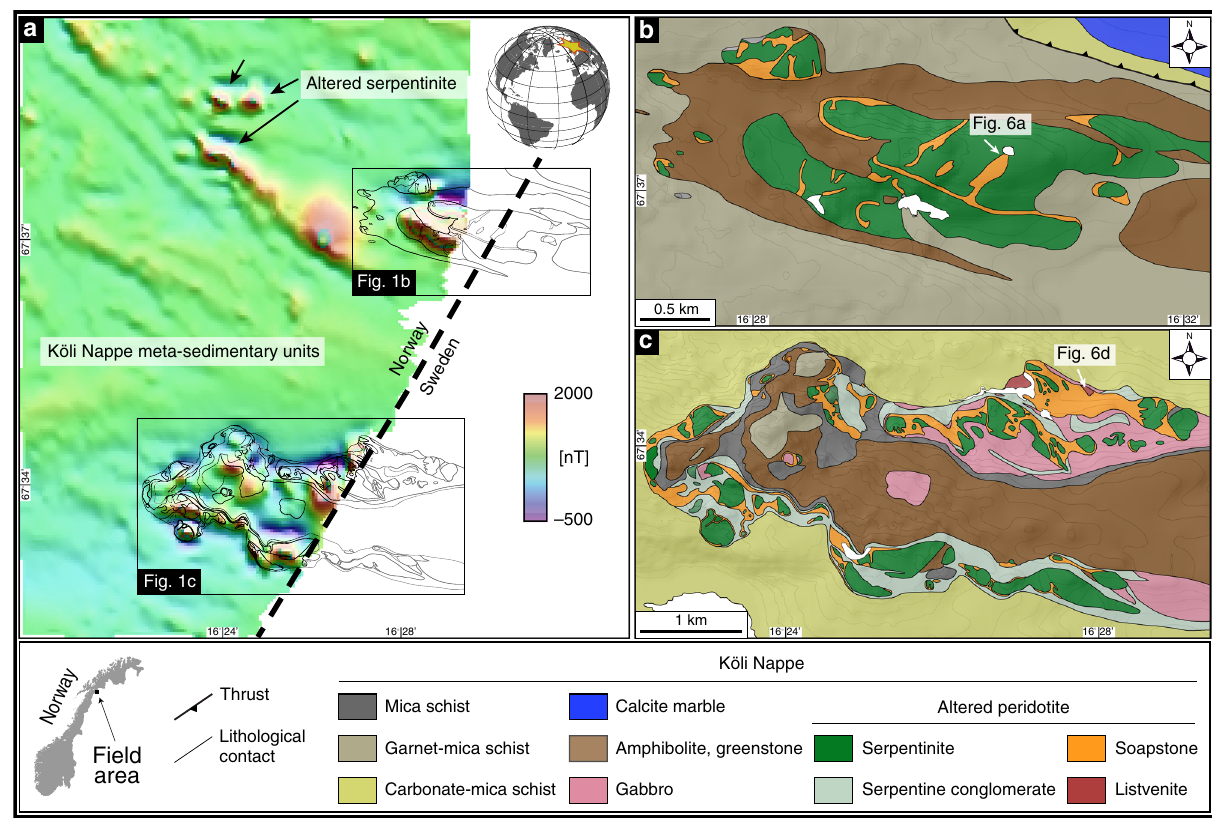
Fig. 1 Aeromagnetic anomaly and geology of the Linnajavri area. a Magnetic anomaly map from the DRAGON aeromagnetic survey of the Linnajavri area showing the location of pristine and altered serpentinite bodies. b , c Geological maps of the Linnajavri Ultrama fi c Complex (LUC) northern b and southern parts c 13, 27 . The location of outcrop-scale magnetic survey lines (Fig. 6) is indicated in b , c . Geological and geophysical data do not exist for the blank